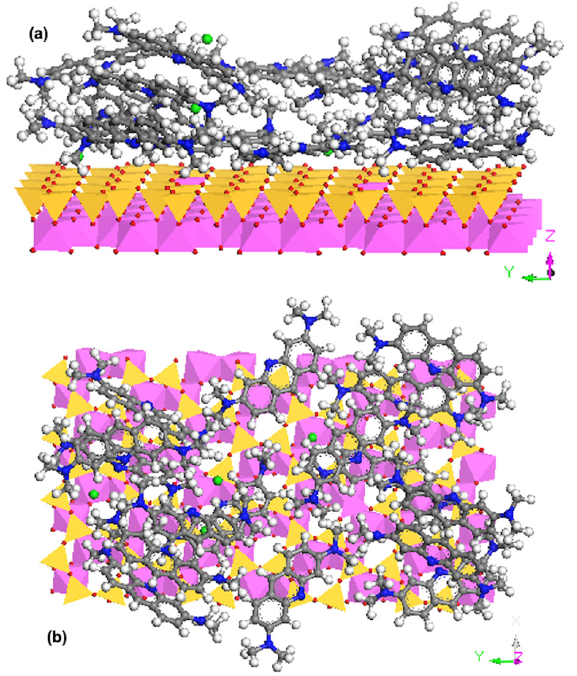
Figure 9. Molecular dynamics simulation showing a bilayer configuration on KAO with an AO sorption of 0.055 mmol/g ( a ) and the influence of Zn 2+ (green dots) on AO sorption ( b ).